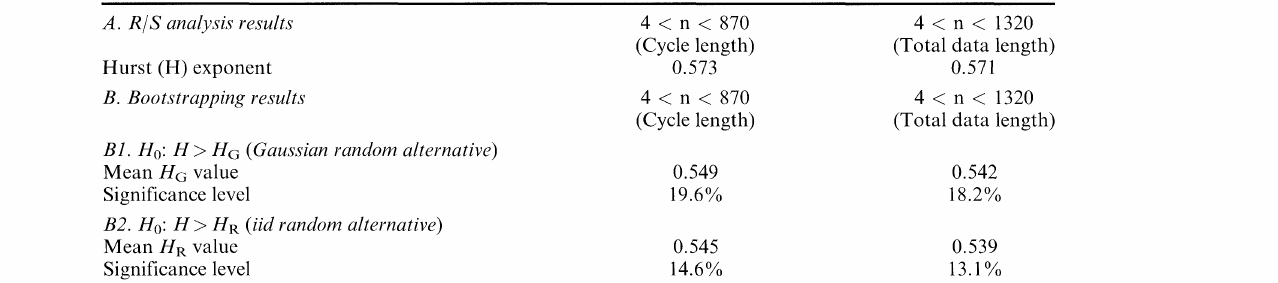
TABLE VII The modified R/S statistic of the daily BP/GRD returns and bootstrapped critical values of the test